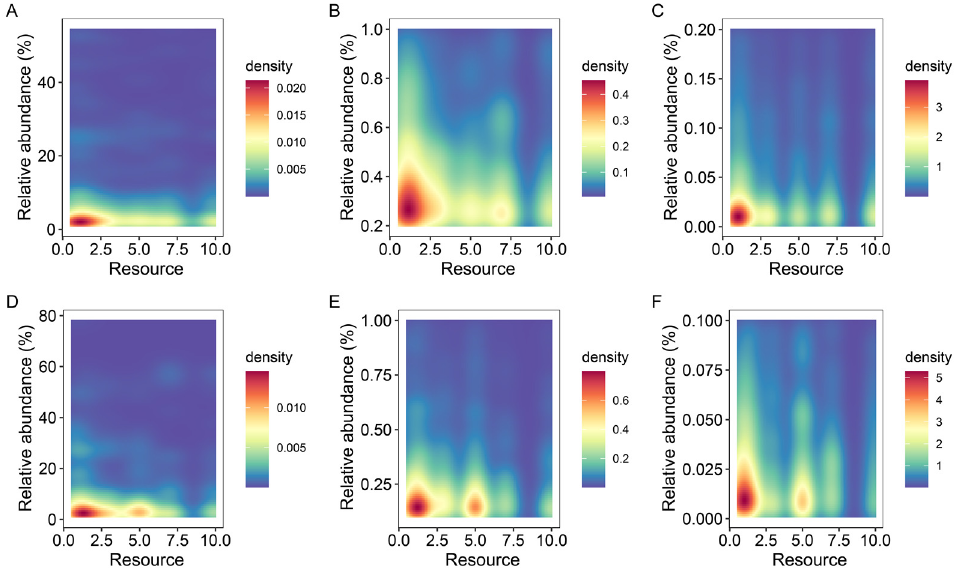
Figure 7. Kernel density diagram of the relationship between resources and relative abundance of microorganisms (fungi and bacteria). In this figure, ( A – C ) are positive groups and ( D – F ) are negative groups; ( A , D ) are microbial taxa with relative abundance greater than 1%, ( B , E ) are microbial taxa with relative abundance between 0.1% and 1%, and ( C , F ) are microbial taxa with relative abundance less than 0.1%. Density is the kernel density of the number of species with corresponding relative abundance at a locus in the figure.